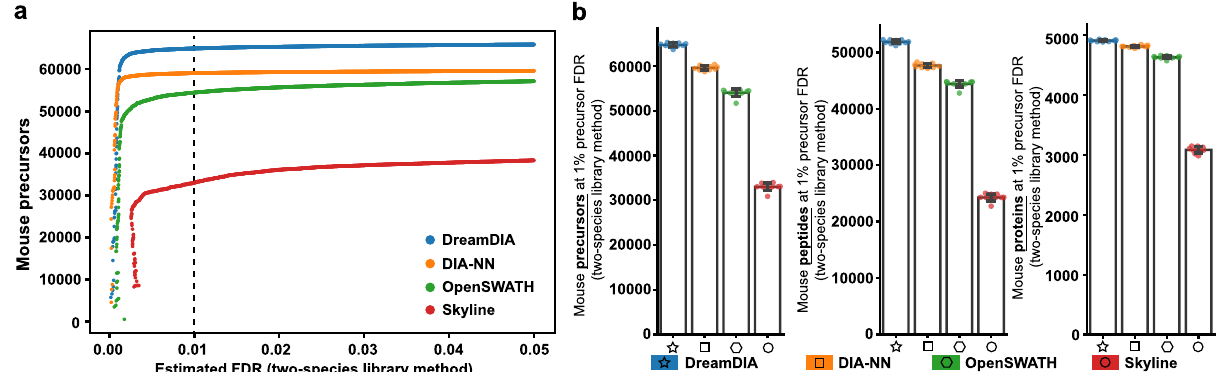
Fig. 2 Identi fi cation performance evaluation of DreamDIA on the mouse cerebellum dataset with two-species library method. a Identi fi cation performance on the S1-1 run of the MCB dataset. The numbers of mouse precursors identi fi ed at different FDRs were plotted. Each point stands for an Arabidopsis (false-positive) precursor and its discriminant score as a cut-off value. The x-axis value stands for the estimated FDR, calculated as the number of Arabidopsis precursor with higher discriminant score than this cut-off value divided by the number of all the precursors with higher discriminant score than this cut-off value. The y-axis value stands for the number of mouse precursors with higher discriminant score than this cut-off value. b Identi fi cation performance on all 10 samples of the MCB dataset. The numbers of mouse precursors, peptides, and proteins at 1% precursor FDR (the respective numbers indicated by the dashed line in ( a )) were plotted. Each error bar stands for the mean and standard deviation of the results of n = 10 biologically independent